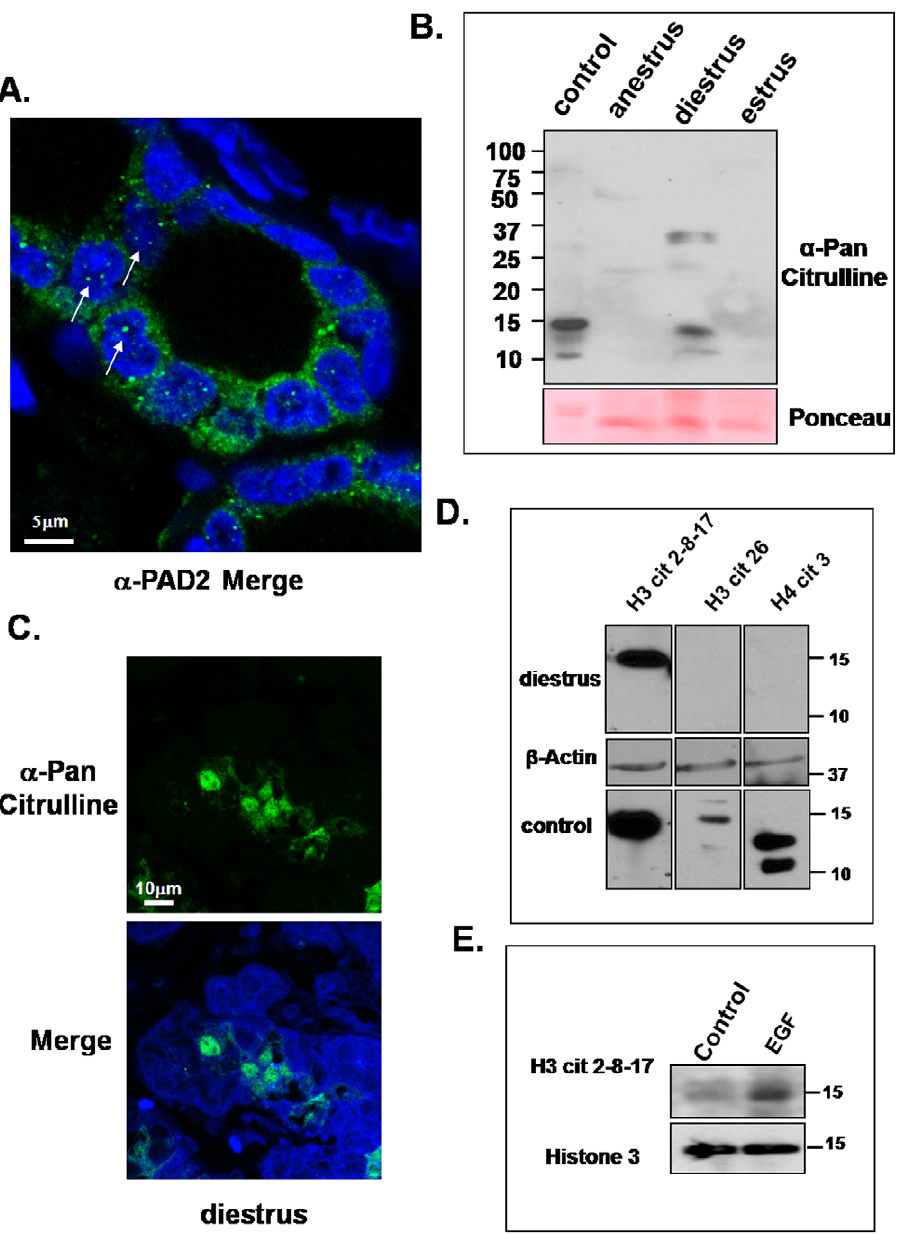
Figure 4. PAD2 association with histone citrullination. (A) PAD2 is detected in the nucleus and cytoplasm of mammary epithelial. PAD2 expression is shown in green and nuclear DAPI stain is in blue with white arrows denoting punctuate PAD2 staining in euchromatic nuclear regions (1000 6 ). (B) PADs target histones from mammary gland epithelial cells for citrullination and this activity is restricted to late diestrus. Canine mammary tissue samples from anestrus, estrus/early diestrus and late diestrus were examined by SDS-PAGE and probed with an anti-pan-citrulline antibody.